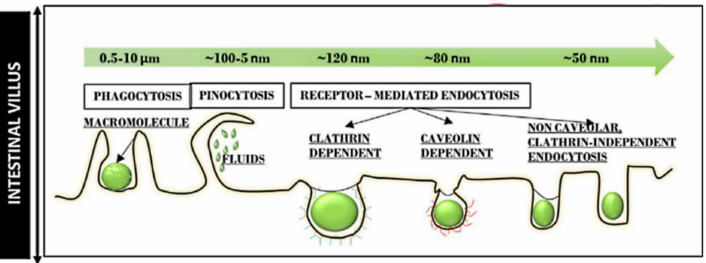
Figure 6. Different endocytosis pathways across the intestinal villus for particles of different sizes. Reproduced with permission from [97], Elsevier Inc.,